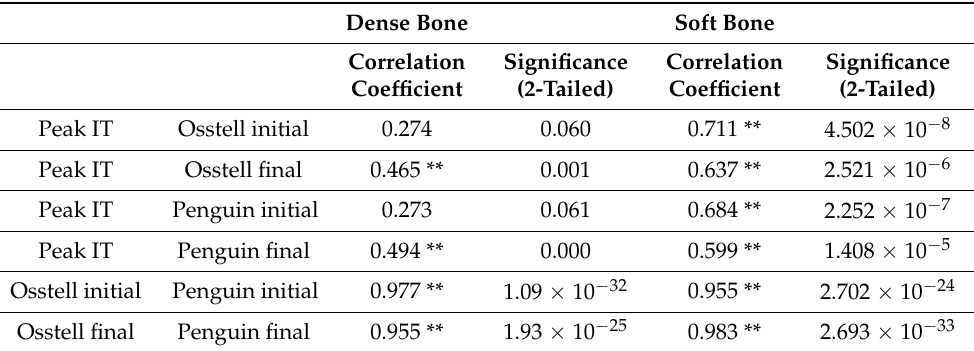
Table 5. Correlation coefficient between the different device measurements using Spearman’s rho correlation coefficient comparing the effect of bone type on the correlation (IT = insertion torque). ** The correlation is significant at the 0.01 level